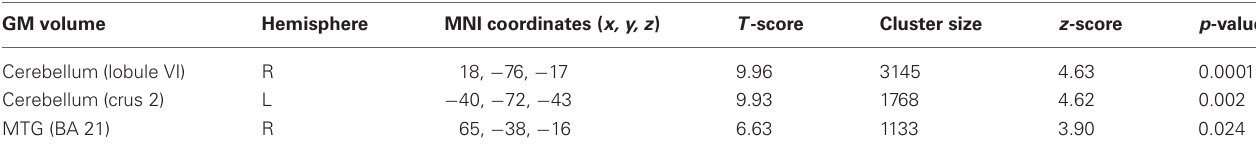
Table 2 | Initial (baseline) GM volume predicts the amount of sequence-specific motor skill learning in a SPFT.